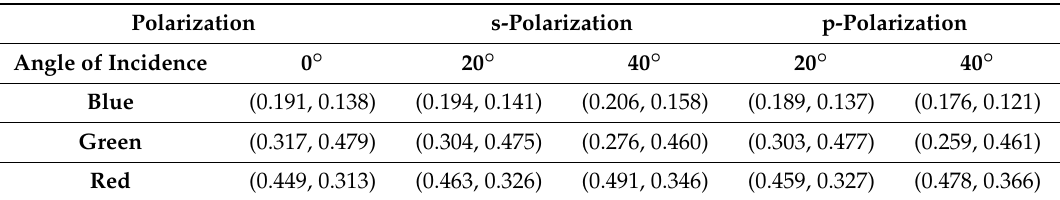
Table 1. Summary of color coordinates for different angles of incidence (0 ◦ , 20 ◦ and 40 ◦ ) and different polarizations (s- and p-polarized